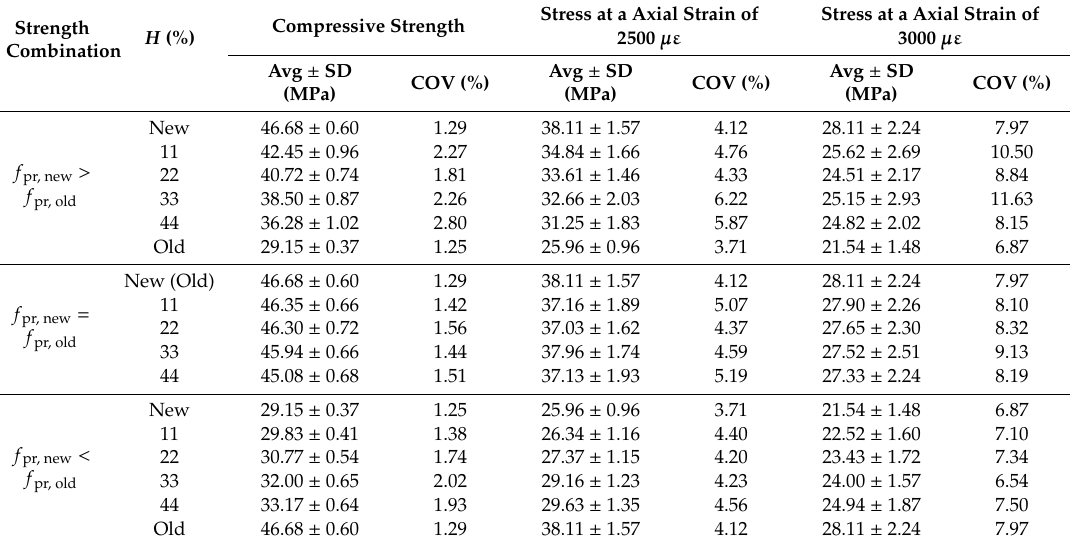
Table 9. Statistical characteristics of concrete stress. COV—coe ffi cient of